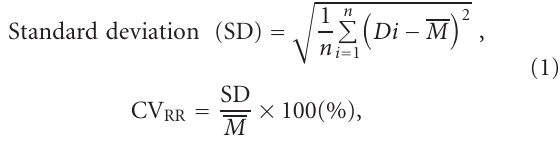
Figure 1: A monitoring device for magnetocardiography (MCG) incorporating a 64-channel SQUID apparatus in a magnetically shielded